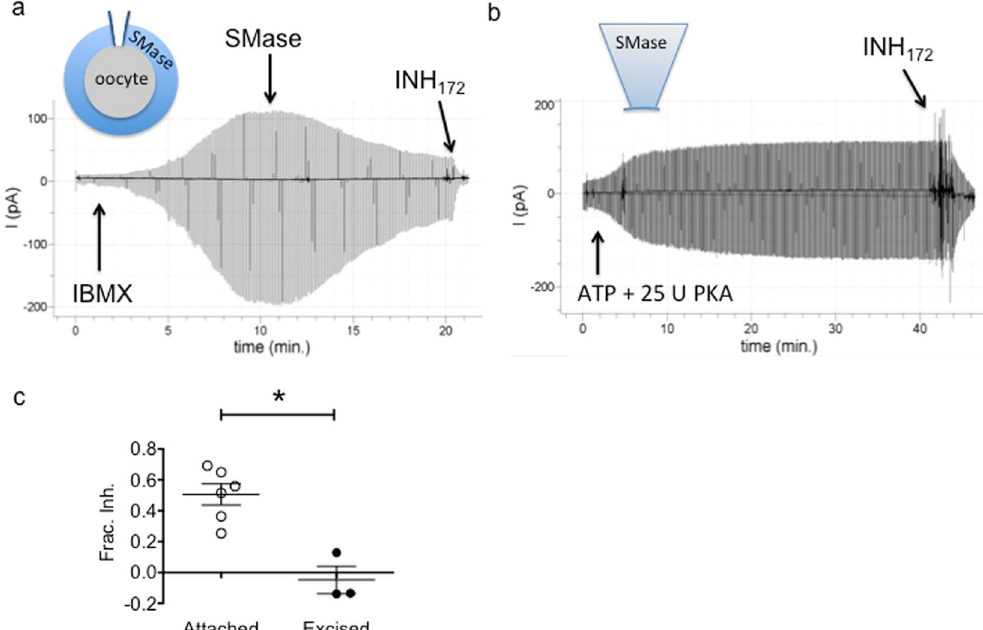
Figure 2. Inhibition is not membrane delimited: ( a ) CFTR currents recorded in the cell-attached configuration after activation with 0.2 mM IBMX were inhibited by 10 μ g/ml SMase in the recording chamber suggesting activation of a signaling pathway that impinged upon the channels in the patch. ( b ) CFTR channels activated with 25 U PKA (expected activation of ~50% max) 36 , and recorded in the excised inside-out patch configuration were insensitive to 10 μ g/mL SMase backfilled into the recording pipette. ( c ) Summary data showing fractional inhibition of currents in each configuration (p = 0.0021, unpaired